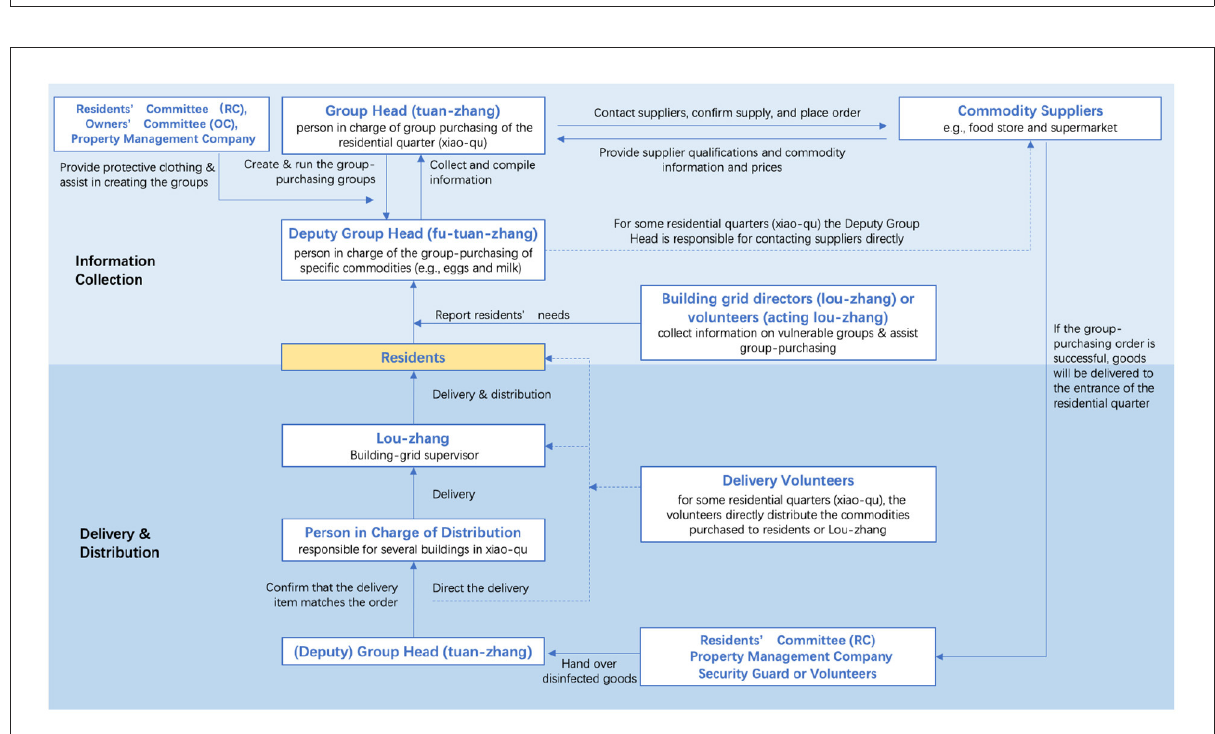
FIGURE4 Group-purchasing network led by residents’ mutual-aid groups under the COVID-19 outbreak.